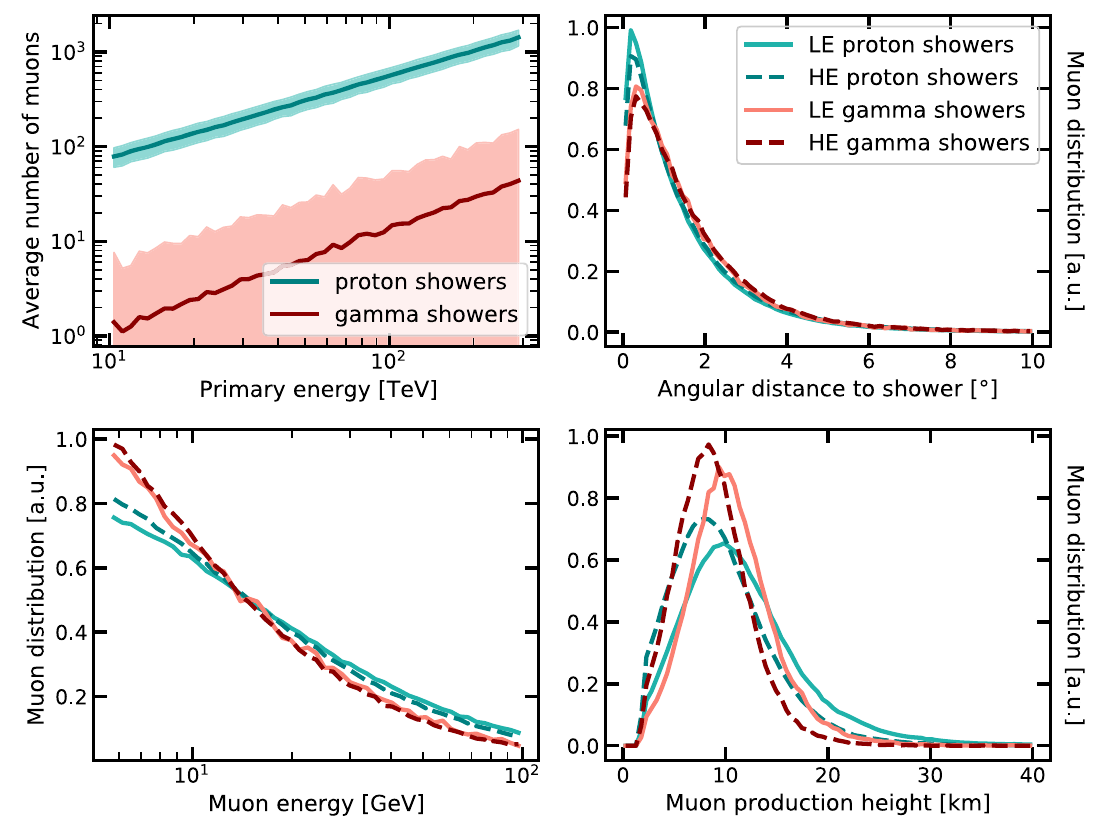
Fig. 4 Characteristics of muons produced in proton- and gamma-ray- initiatedshowers.Thetopleftpanelshowstheaveragenumberofmuons present as a function of primary energy, with the shaded area represent- ing the standard deviation. The remaining panels show the distributions of angular distance to the shower, energy and production height for